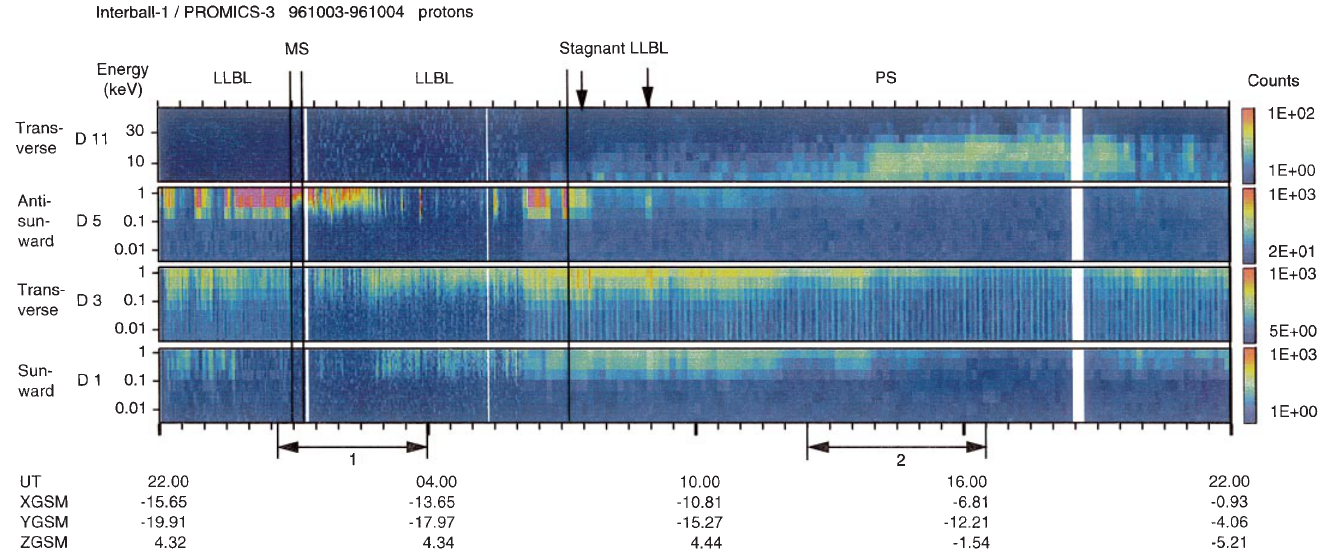
Fig. 11. Spectrogram from Interball-1 covering 24 h from 22 UT on October 3 to 22 UT on October 4, 1996. During this time nearly conjugate measurements were performed with Interball-1 and Interball-2. Interball-1 was inbound and spent the first part of the